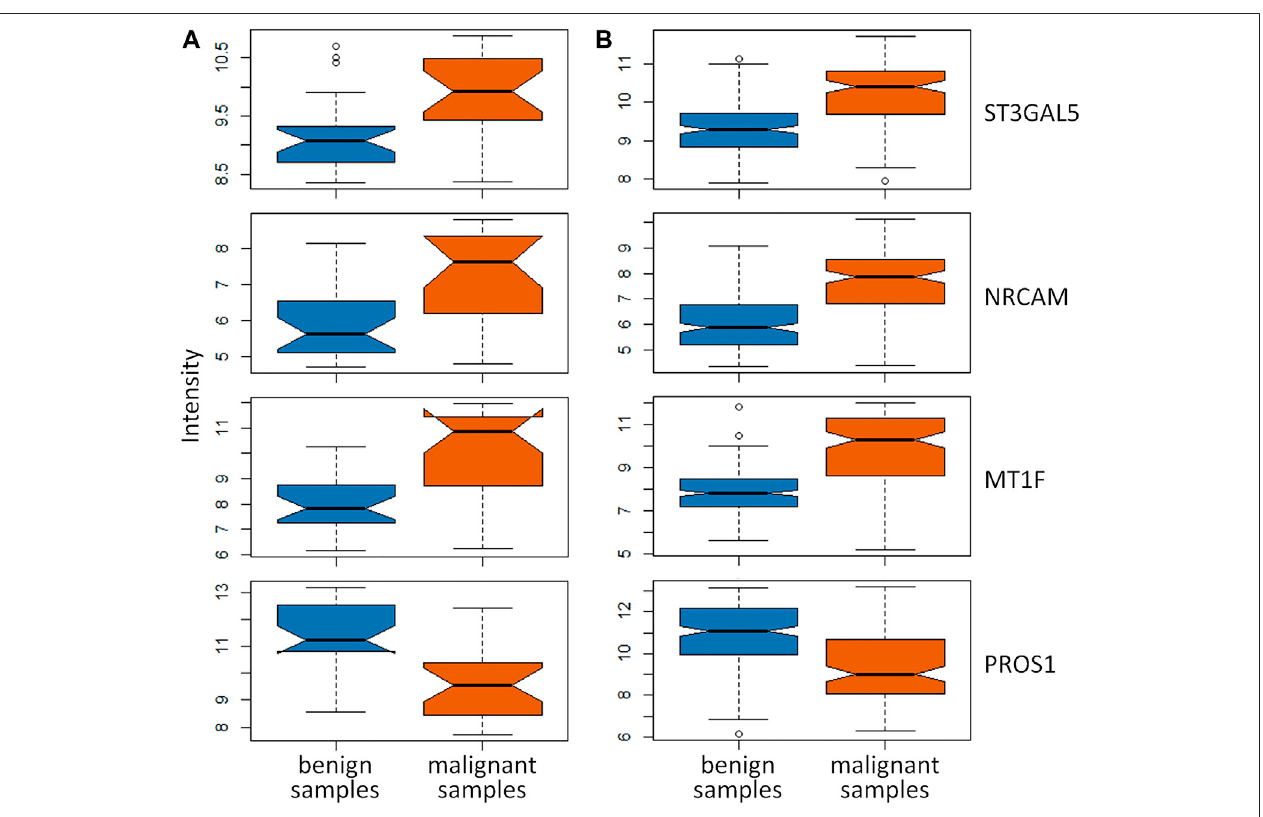
FIGURE4| Validationofkeygenesidenti fi edbybothDEGsidenti fi edbythefeatureselectionmethodandhubgenesinthegraymoduleusingWGCNA.Theboxplotsof these key genes between malignant and benign thyroid nodules were validated in the independent dataset detected by (A) GPL5175 and (B) GPL14961